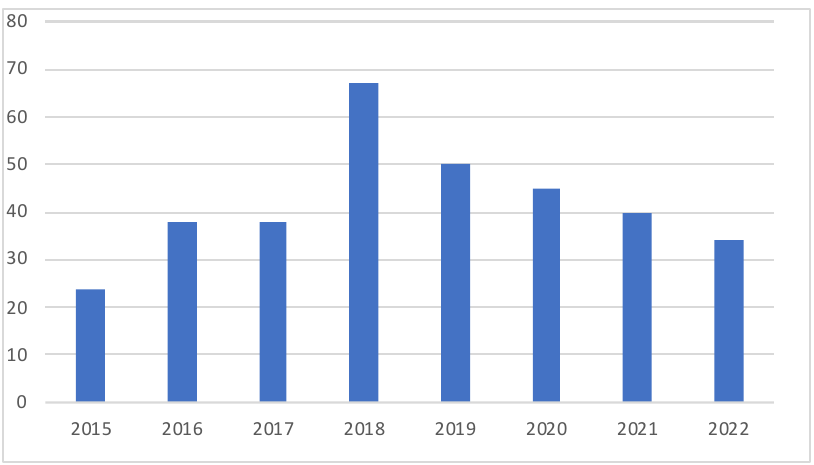
Figure 3. This picture shows the literature distribution in the field of log analysis in the last eight